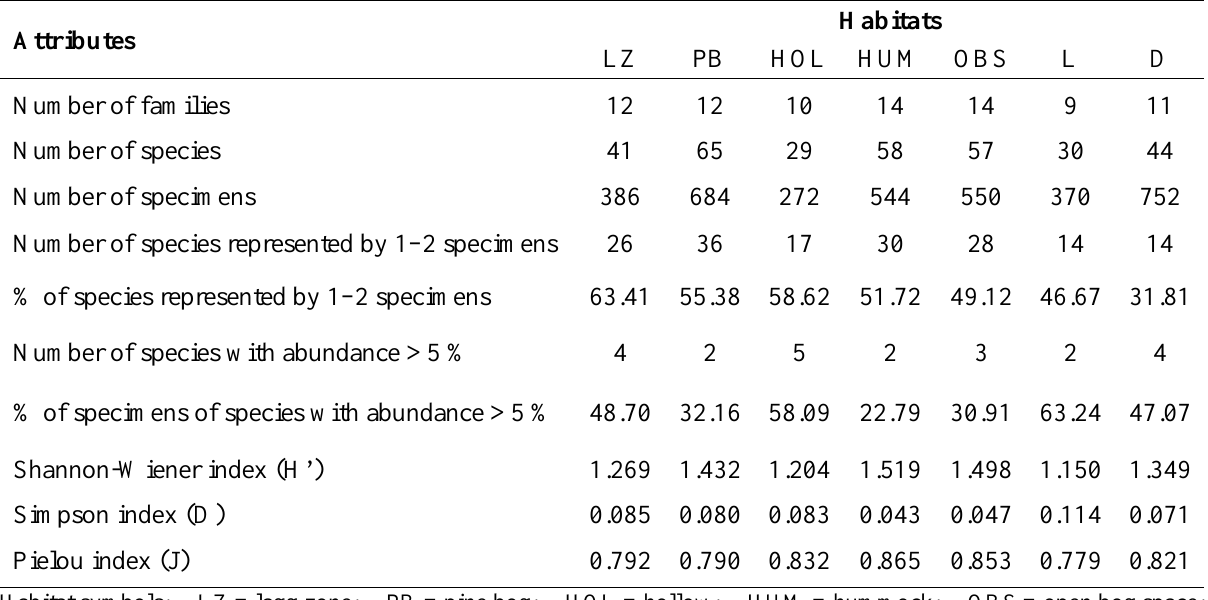
Table 2. The main attributes of the beetle